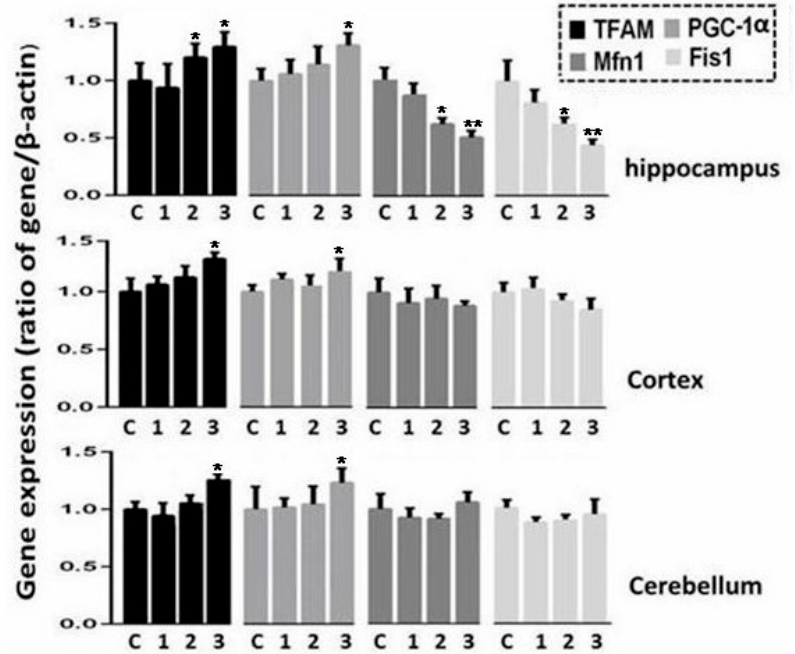
Figure 6. Change in expression of genes involved in biogenesis, transcription regulation (TFAM, PGC-1 α ) and mitochondrial dynamics (Mfn1, Fis1) in rat brain regions after radiation exposure. The level of gene expression in unirradiated rats is expressed as 1. The data are presented as mean ± SD from 4–5 independent experiments. Statistical significance was set at * p < 0.05, ** p < 0.01.